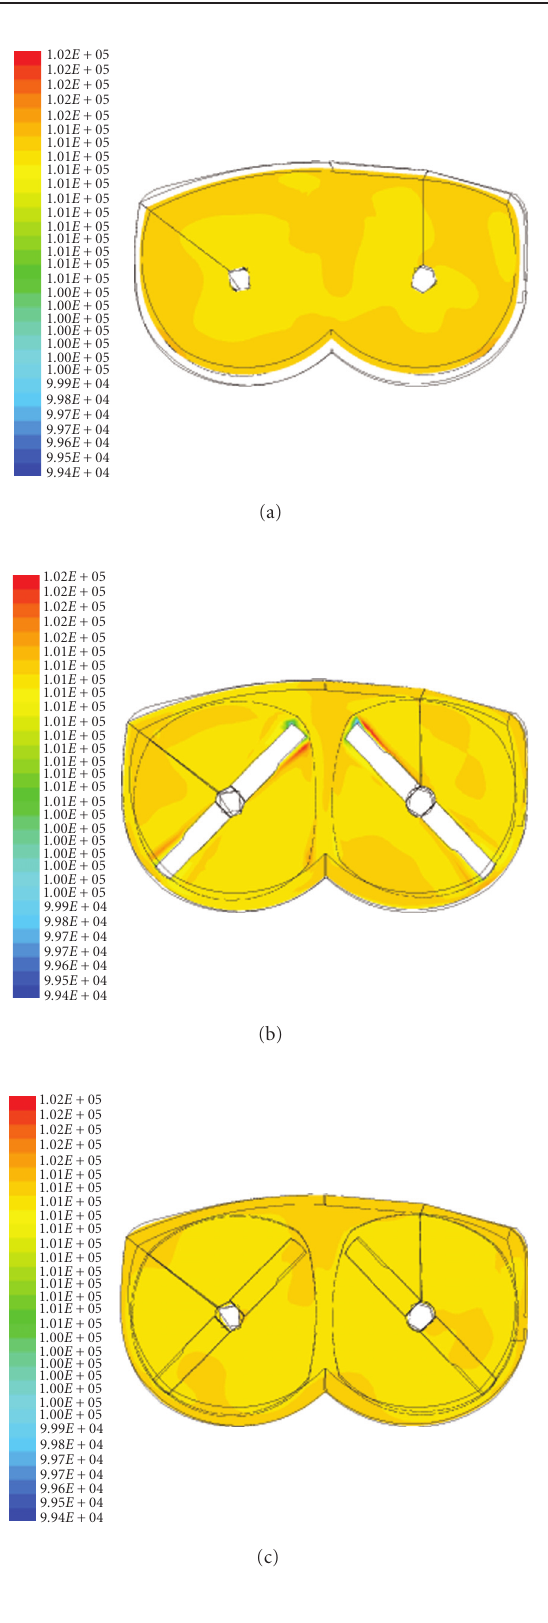
Figure 17: Static pressure contour at the horizontal planes (Pa): (a) plane above the blade, (b)plane through the blade, and (c) plane below the blade.